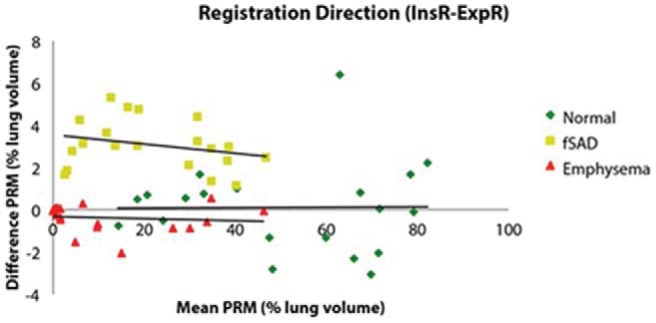
Impact of registration direction on PRM. Registering the inspiration to the expiration resulted in higher percentages of tissue identified as air trapping. Because tissue compresses upon expiration, tissue with functional small airways disease compressed less and remained a larger percentage of the total lung volume than if measured on the inspiration volume. Differences of PRMNormal and PRMEmph were close to 0, but PRMNormal has a slightly larger 95% CI.